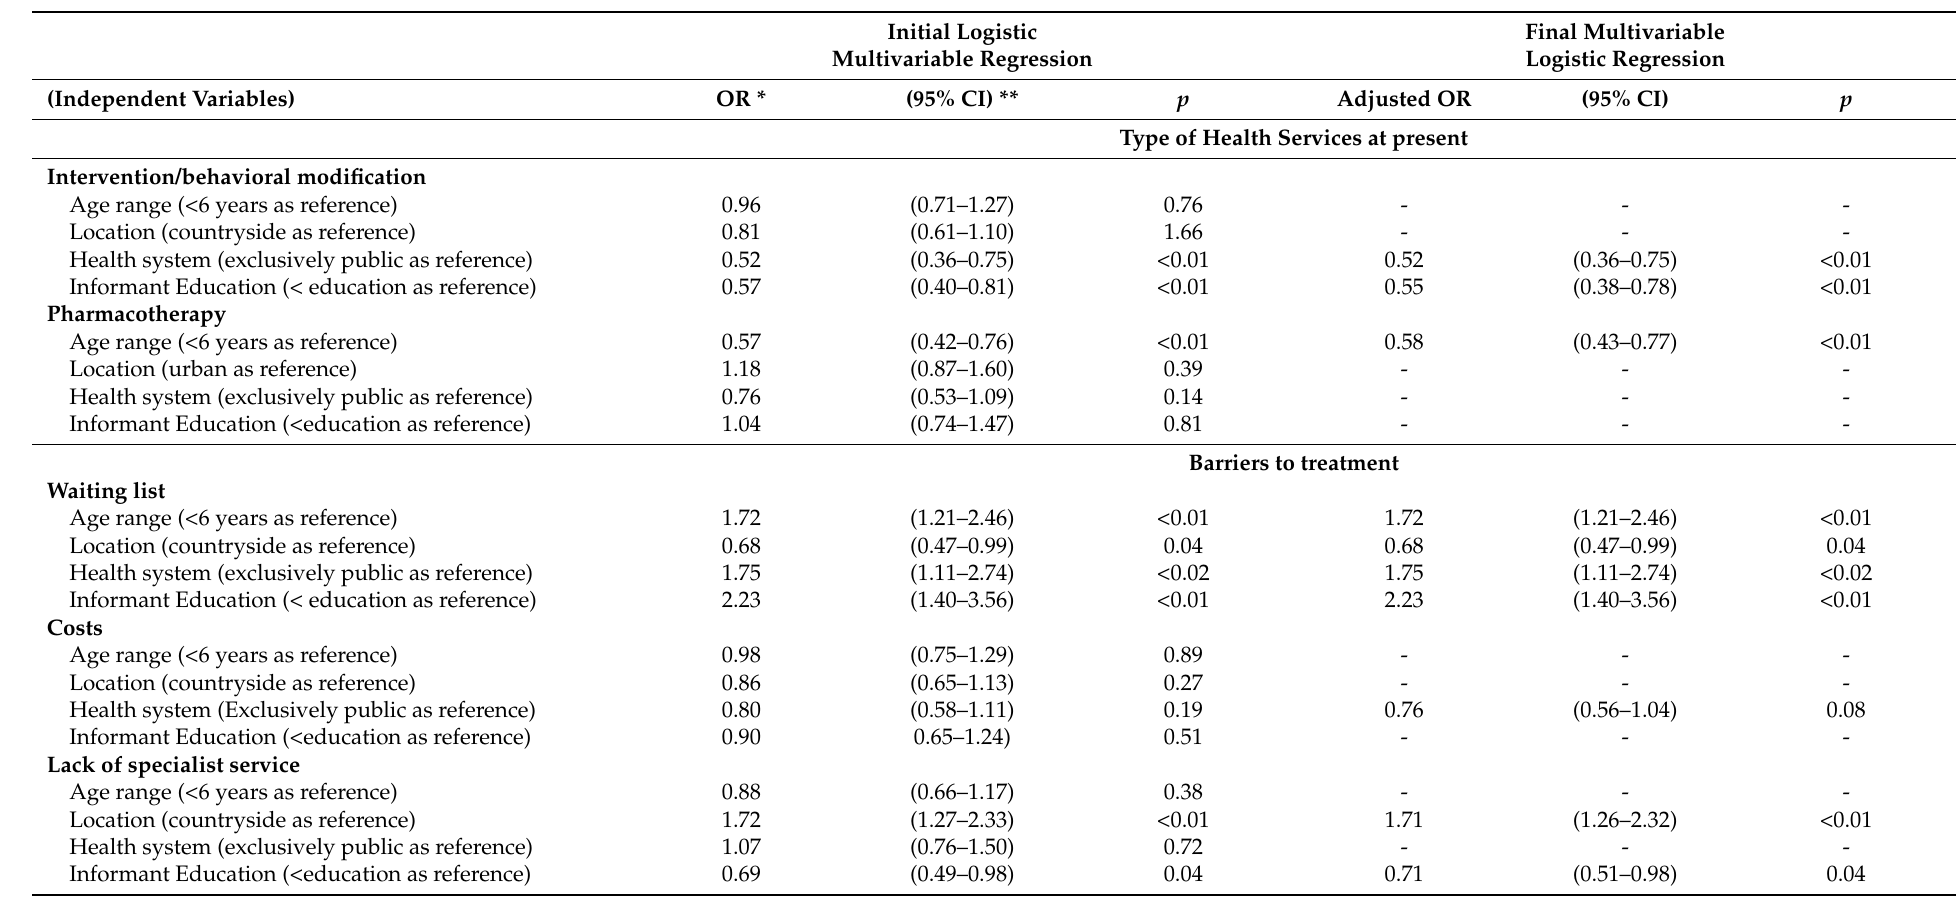
Table 4. Sociodemographic factors related to the most commonly health services and main access barriers (N =